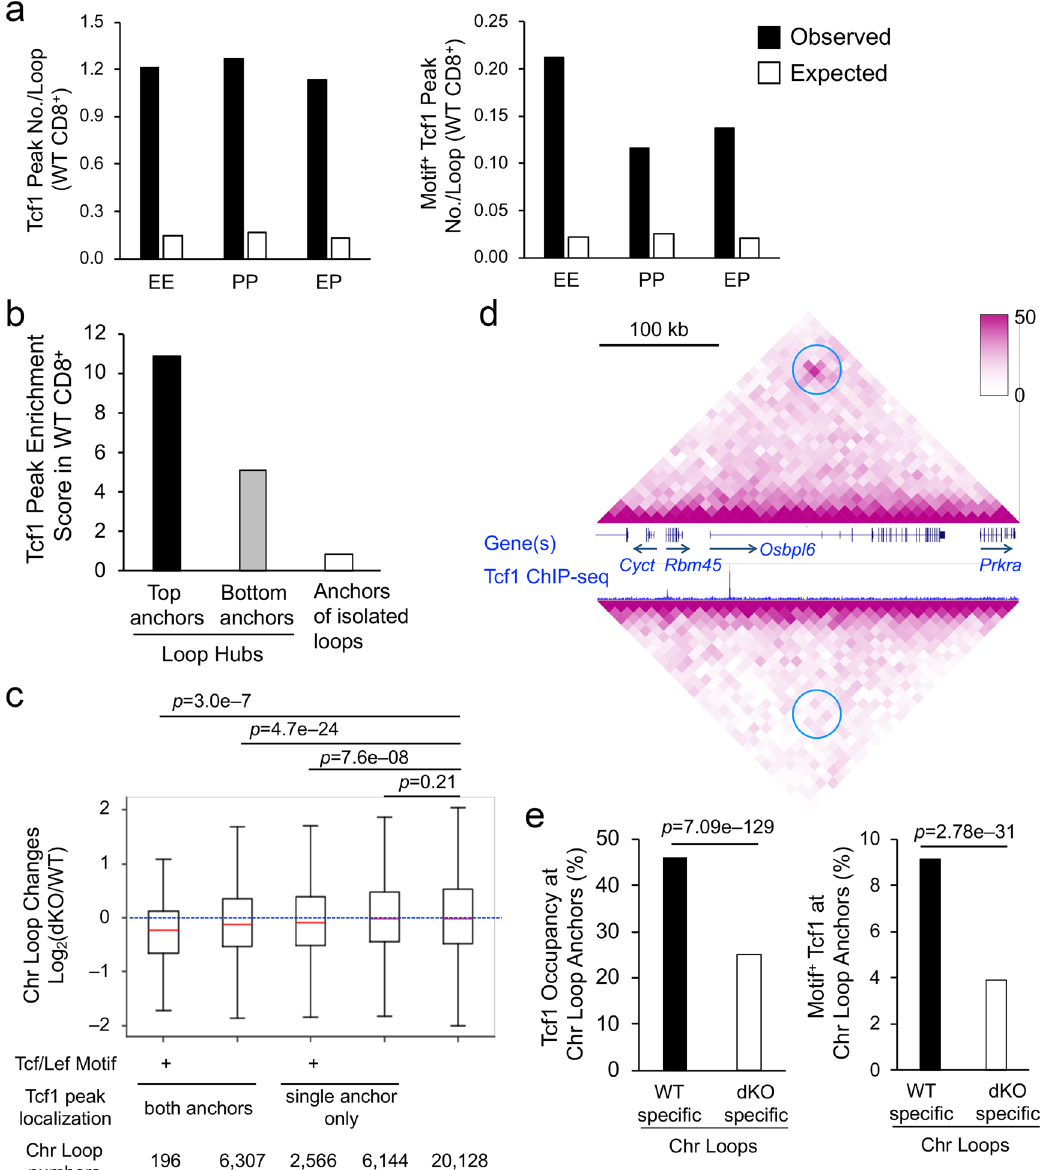
Fig. 2 Tcf1 and Lef1 control interaction strength in chromatin loops in CD8 + T cells. a Tcf1 peaks are enriched in anchors of chromatin loops. Chromatin loops were called using HiCCUPS and allocated into different groups according to anchor annotation in promoters (P) or enhancers (E). The observed numbers of all (left) and Motif + (right) Tcf1 peaks per loop were identi fi ed for each group, and the expected numbers were based on genome average. b Tcf1 peaks are enriched in the hubs of the chromatin loop network. From the network of chromatin loops in WT CD8 + T cells, 306 hubs were identi fi ed as highly interconnected clusters of interactions. Anchors of hubs were ranked according to interaction frequency, and the top (No. 1) and bottom (last) anchors from each hub were collected and analyzed for Tcf1 peak enrichment. Anchors of the isolated loops were analyzed as a control. c Tcf1/Lef1 de fi ciency diminishes the strength of Tcf1-associated chromatin loops. Chromatin loops identi fi ed in WT and dKO CD8 + T cells were allocated into different groups based on the presence of total and Motif + Tcf1 peaks at a single or both loop anchors, and changes in loop strength were assessed in each group. The blue-dotted line denotes no change in loop strength. Boxplot annotation is the same as Fig. 1e. d Select differential chromatin loop at the Rbm45 to Prkra gene loci, as denoted by blue circles. e Tcf1 peaks are enriched in anchors of WT-speci fi c chromatin loops. Differential chromatin loops were called using edgeR, and the frequency of all (left) and Motif + Tcf1 peaks (right) at anchors of WT- or dKO-speci fi c chromatin loops is shown. The statistical signi fi cance is assessed using one-sided binomial CD8 + T cells, which showed distinct expression clusters on PCA modulate SE activity and chromatin loop strength in mature CD8 + T cells. (Supplementary Fig. 4c). By criteria of ≥ 2-fold expression changes and FDR < 0.05, we found that 258 genes were downregulated, while 313 genes were upregulated in dKO CD8 + T cells. Functional annotation using DAVID Bioinformatics Resources 41 showed that Tcf1 and Lef1 repress non-T lineage-enriched genes in CD8 + “ immunity ” , “ adaptive immunity ” and “ innate immunity ” were the T cells . To de fi ne the impact of Tcf1/Lef1 de fi ciency on CD8 + T top enriched functional clusters in both down- and upregulated cell biology, RNA-seq analysis was performed on WT and dKO